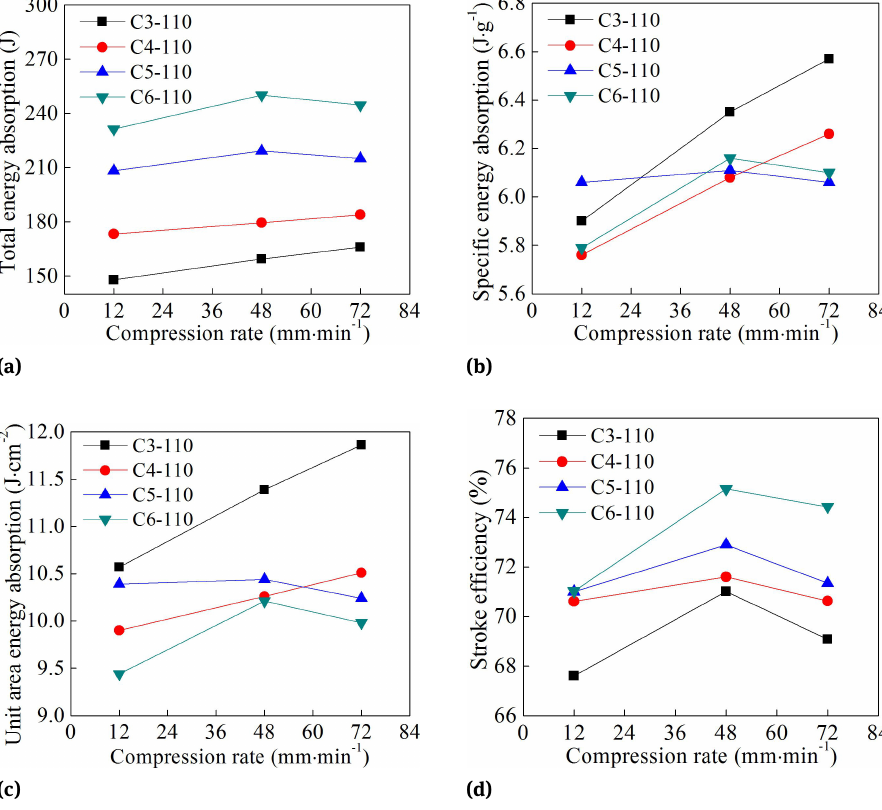
Figure 18: Effects of different compression rates on cushioning energy absorption parameters of paper corrugation tube along Y direction: (a) total energy absorption; (b) specific energy absorption; (c) unit area energy absorption; (d) stroke